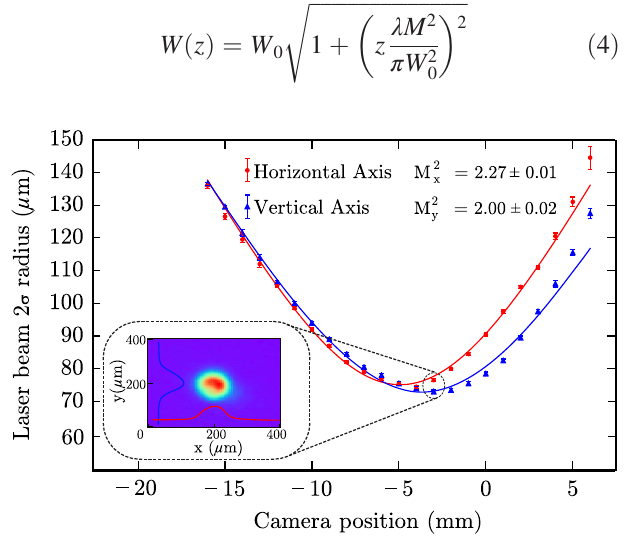
ffiffiffiffiffiffiffiffiffiffiffiffiffiffiffiffiffiffiffiffiffiffiffiffiffiffiffiffiffi